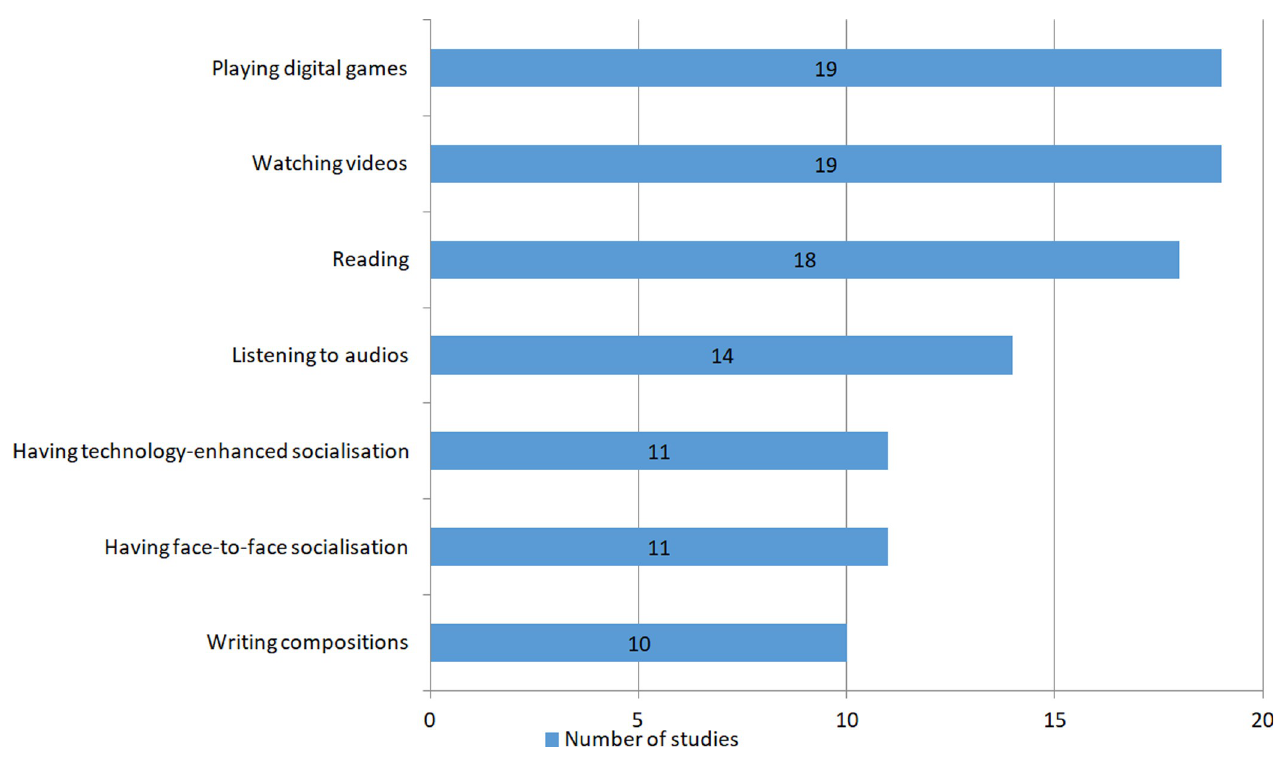
Fig 3. Types of ELL